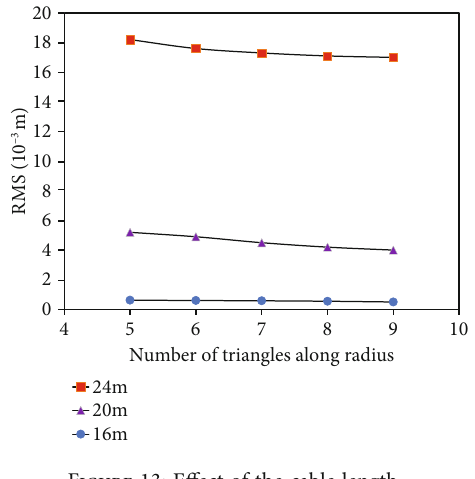
Figure 13: E ff ect of the cable length.